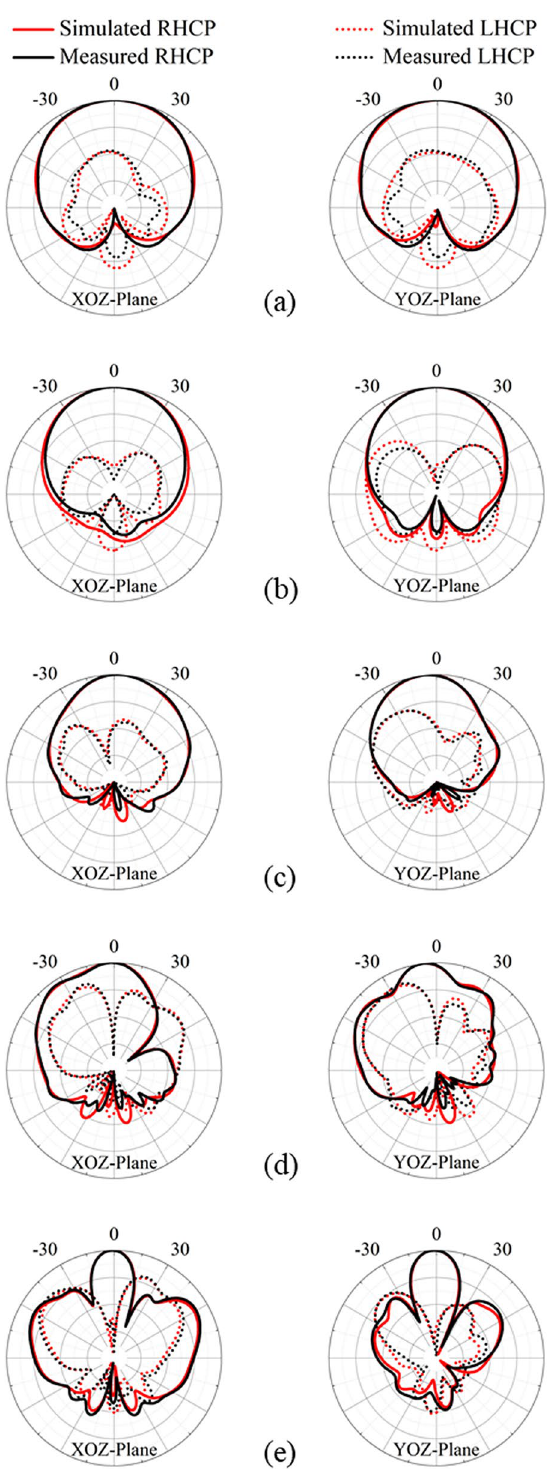
Figure 11. Simulated and measured normalized radiation patterns of the proposed CP antenna. ( a ) 1.8 GHz, ( b ) 2.7 GHz, ( c ) 4 GHz, ( d ) 5.3 GHz, ( e ) 6